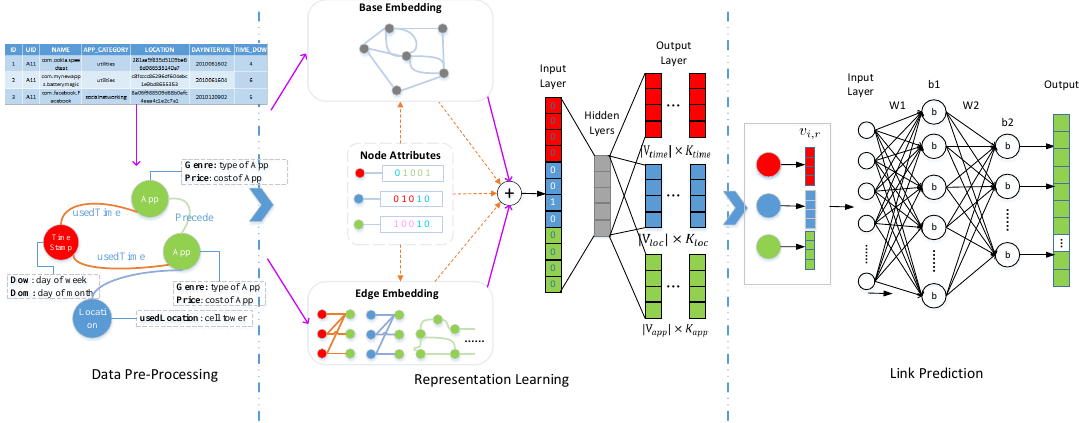
Figure 1. Network embedding based framework for App usage